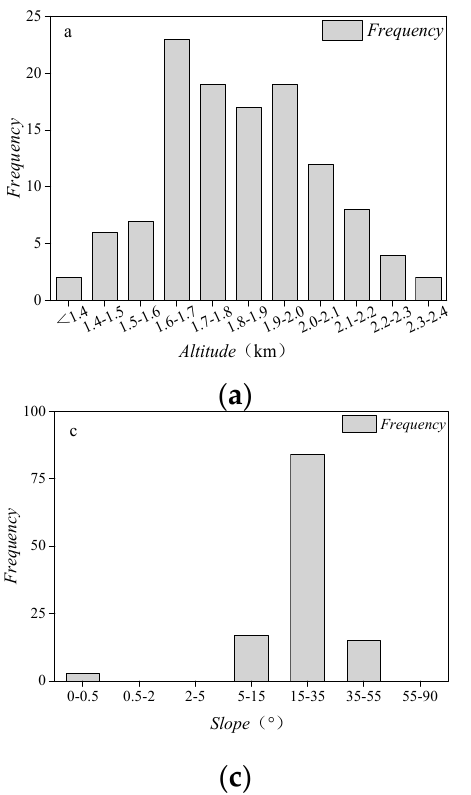
Figure 2. The frequency histogram of terrain variables. ( a ) altitude; ( b ) aspect. The aspect is measured counterclockwise in degrees, ranging from 0 degrees (true north) to 360 degrees (still true north, one cycle); and, ( c ) slope. According to the Geomorphological Survey and Geomorphologic Mapping Committee of the International Geographical Union, the grades of slopes are classified, as follows: 0°–